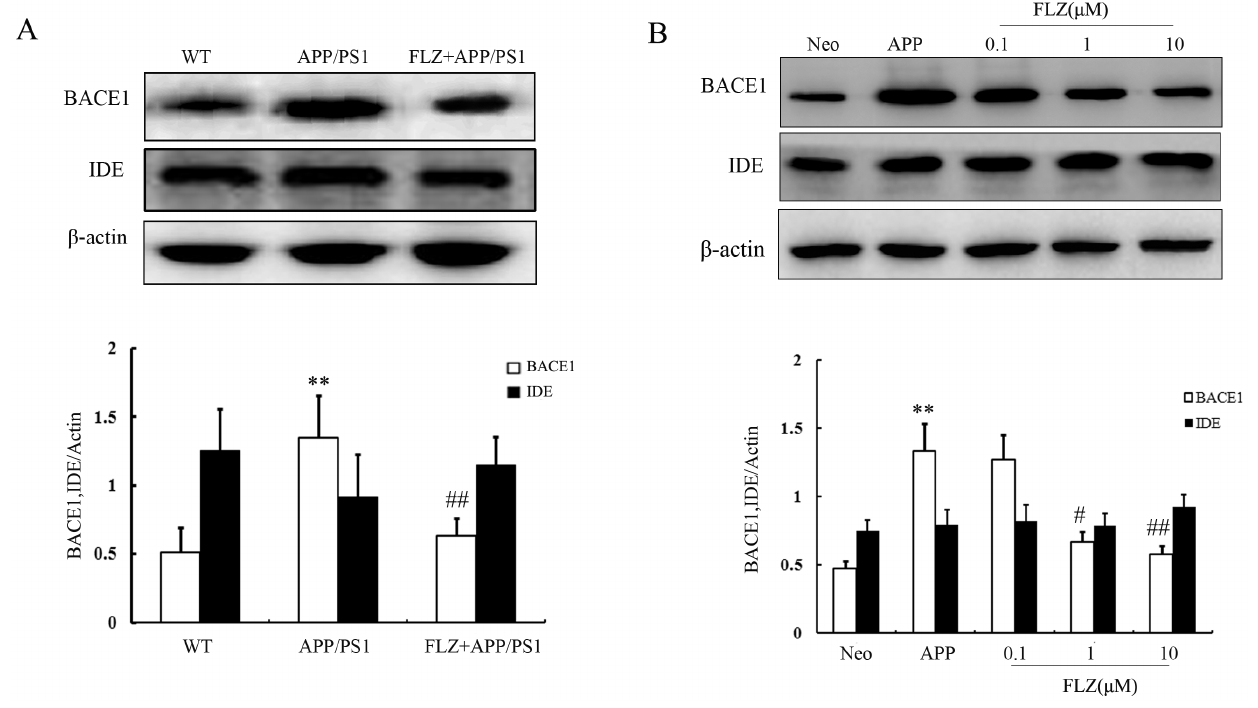
Figure 6. FLZ decreased the expression of BACE1 and did not affect the expression of IDE. APP/PS1 double transgenic mice were orally treated with FLZ 150 mg/kg for 20 weeks. SH-SY5Y (APPwt/swe) cells were grown in ‘‘stimulating medium’’ containing 50% DMEM, 50% Opti-MEM, 0.5% FBS, 200 m g/ml G418 and 10 mM butyric acid sodium salt for 12 h to induce the transgene expression. FLZ (0.1, 1 and 10 m M) were incubated with cells for 24 h. (A) Western blot assay of BACE1 and IDE in the hippocampus of APP/PS1 mice treated with FLZ. A representative immunoblot from 4 mice was shown. Results are expressed as mean 6 SD. * P , 0.05 vs . WT mice; # P , 0.05 vs . APP/PS1 mice. (B) Western blot assay of BACE1 and IDE in SH-SY5Y (APPwt/swe) cells treated with FLZ. A representative immunoblot from four independent experiments was shown. Results were expressed as mean 6 SD. ** P , 0.01 vs . Neo SH-SY5Y cells, # P , 0.05, ## P , 0.01 vs . solvent-treated SH-SY5Y (APPwt/swe) cells.